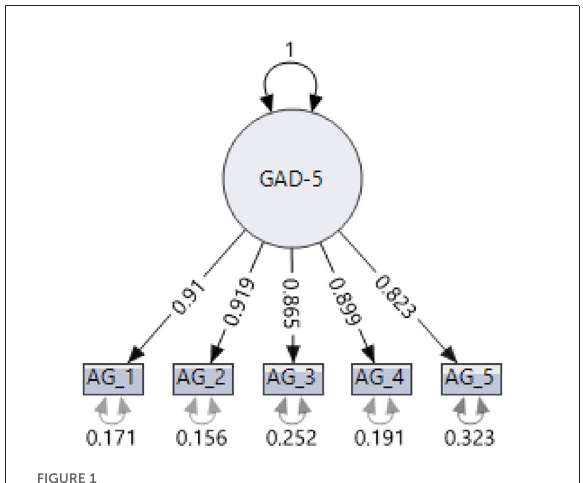
FIGURE1 Results of the confirmatory factor analysis of the